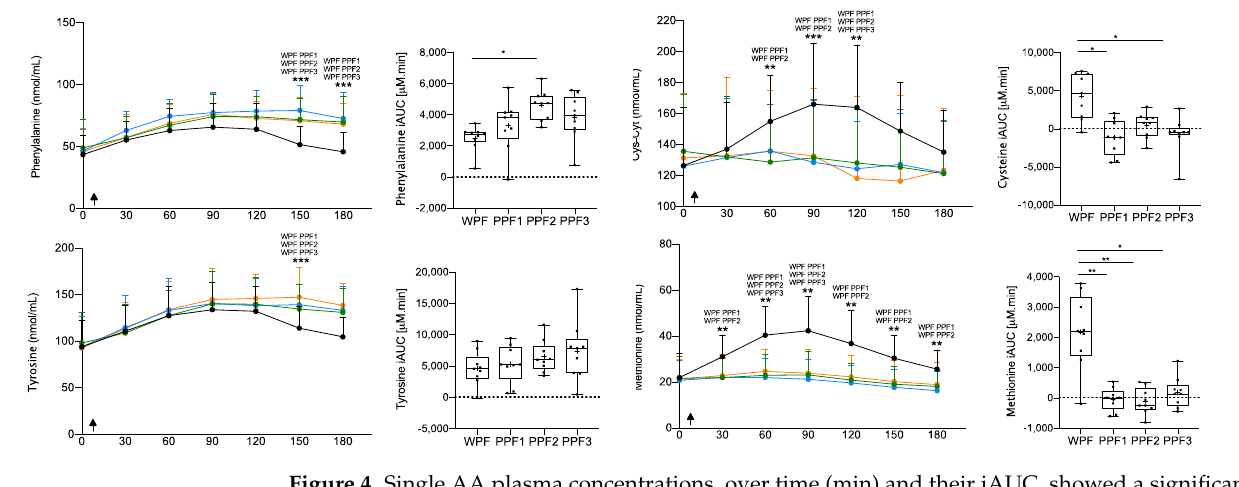
Figure 4. Single AA plasma concentrations, over time (min) and their iAUC, showed a significantly different response post WPF than PPF 1, 2, or 3 meals. Values are mean ± SD (n = 9). Arrows indicate the ingestion of the meal. Concentration over time data were assessed by 2-way repeated measure- ments (time x treatment) ANOVA, and iAUC was compared with a 1-way repeated measures (treat- ment) ANOVA. Significant at p < 0.05 (*), p < 0.01 (**) or p < 0.001 (***). The products’ names above asterisk indicate the treatments in which postprandial AA concentrations significantly differ at that time point. BCAA, branched-chain amino acids; IAA, indispensable amino acids; iAUC, incremental area under the curve; PPF, plant protein fibre; WPF, whey protein fibre.